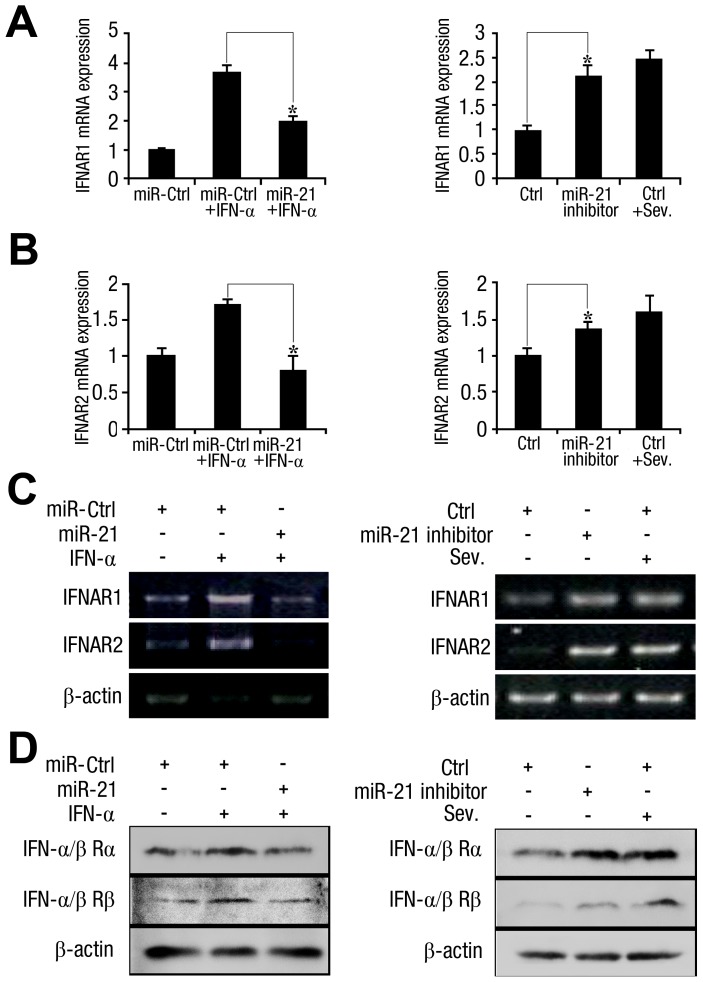
The antiviral IFN-α response is downregulated by miR-21 in hepatocytes.Huh7 hepatocytes were transfected with miR-21 mimics or control mimics, miR-21 inhibitor or control inhibitor (final concentration, 50 nM), as indicated. After transfection for 30 h, the cells were treated with recombinant human IFN-α (100 U/ml) or infected with Sendai virus (SeV), as indicated. After 12 h, IFNAR1 and IFNAR2 mRNA and protein expression was determined by qPCR (A, B), RT-PCR (C) and Western blot analysis (D), respectively. Data are shown as the meansSD (n = 3) from one representative experiment. Similar results were obtained in three independent experiments. **, p<0.01; *, p<0.05.